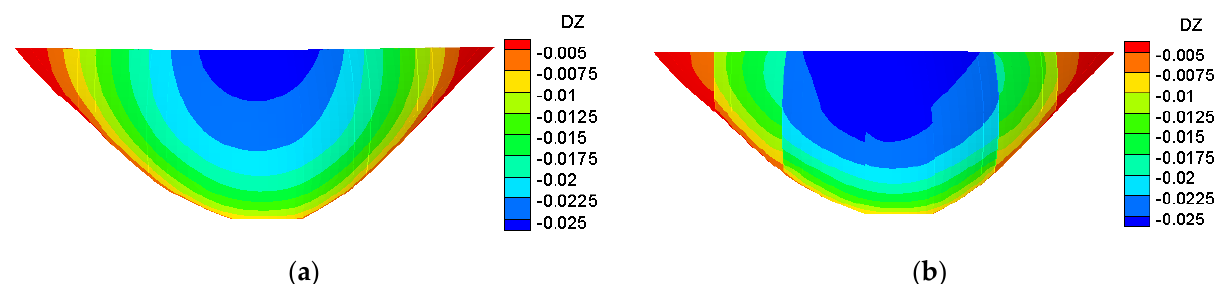
Figure 17. The distribution of vertical displacement on the arch-dam upstream surface of different transverse joint models. ( a ) M1. ( b )